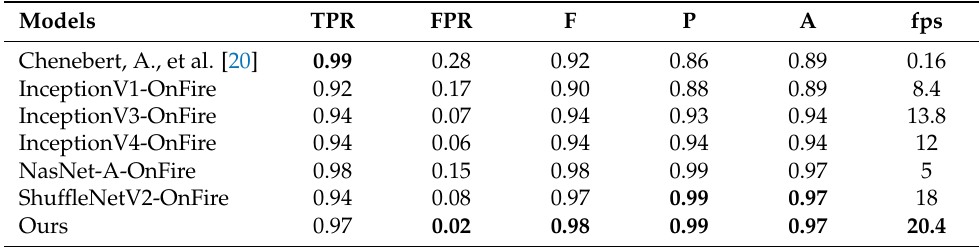
Table 1. This table presents the quantitative results of the proposed method on the furg fire dataset [15], in comparison with prior works for the full-frame classification problem. The bolded values highlight each metric’s top value